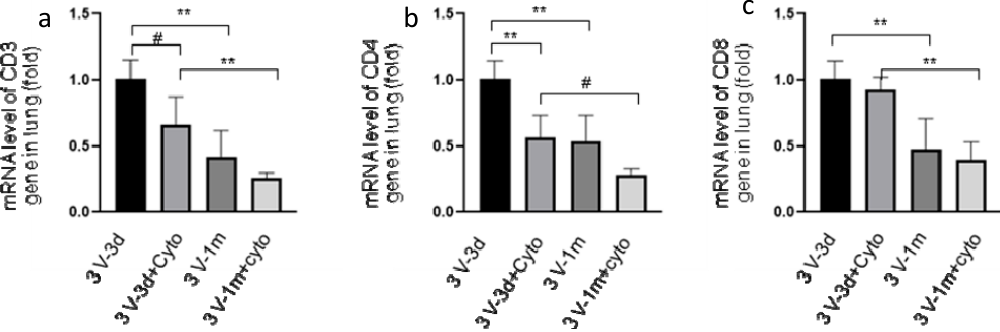
Figure 2. CD3 (cluster of differentiation 3) ( a ), CD4 ( b ), and CD8 ( c ) gene expression in mouse lungs determined by real-time RT-qPCR. RNA was isolated from mouse lung tissues, which were collected at days 3 and 33 after the last round of vector transduction from both groups of mice with or without cyclophosphamide treatments. The expression of CD3 (left panel), CD4 (middle panel), and CD8 (right panel) genes was normalized with 18S. 3V-3d: samples collected at day 3 following the third round of vector delivery; 3V-3d + cyto: samples collected from mice with the same time frame as those of 3v-3d but with cyclophosphamide treatments; 3V-1m: samples collected from mice in one month following the last round of vector delivery; 3v-1m + cyto: samples collected from mice with the same time frame as those of 3V-1m, but with cyclophosphamide treatments. Data are presented as mean ± SD (standard deviation), n = 5 for all groups. #: p < 0.05; **: p < 0.01.